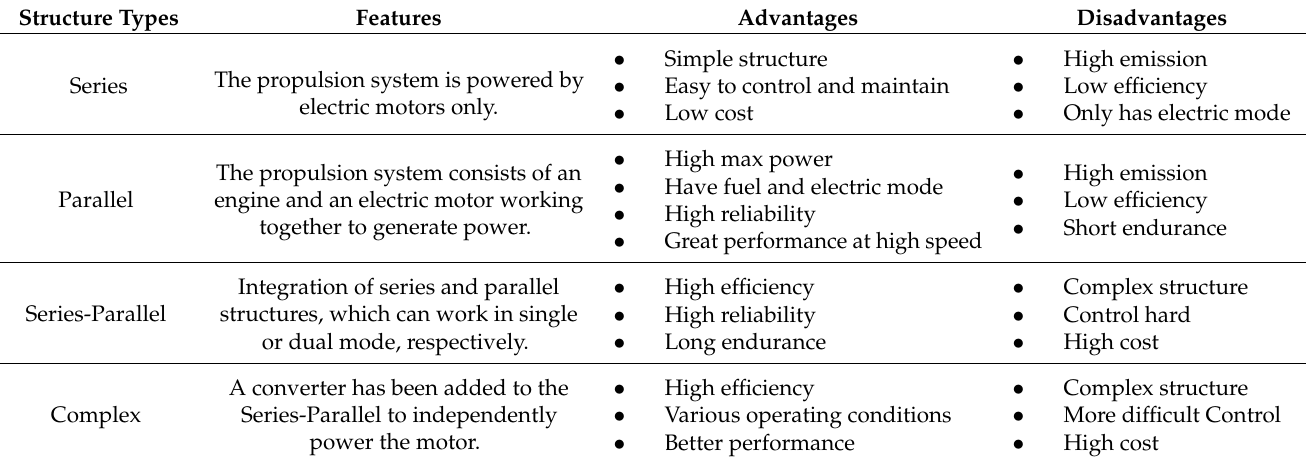
Table 4. Comparison of four hybrid propulsion